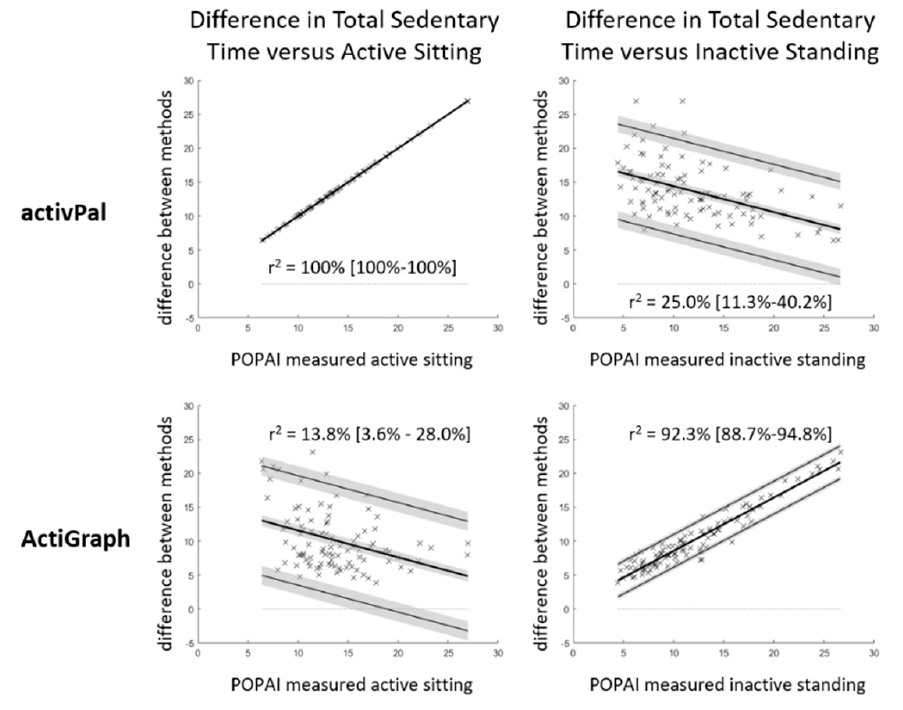
Figure 5. Modified Bland-Altman plots of the bias for total sedentary time versus active sitting and inactive standing. Data presented in % of waking hours (100% equals 15.0 h, n = 100). Indicated is the bias (bold line) and 95% limits of agreement (thin lines), both with 95% confidence interval (in grey). The r 2 indicates the proportion of the bias for total sedentary time that can be explained by active sitting and inactive standing.